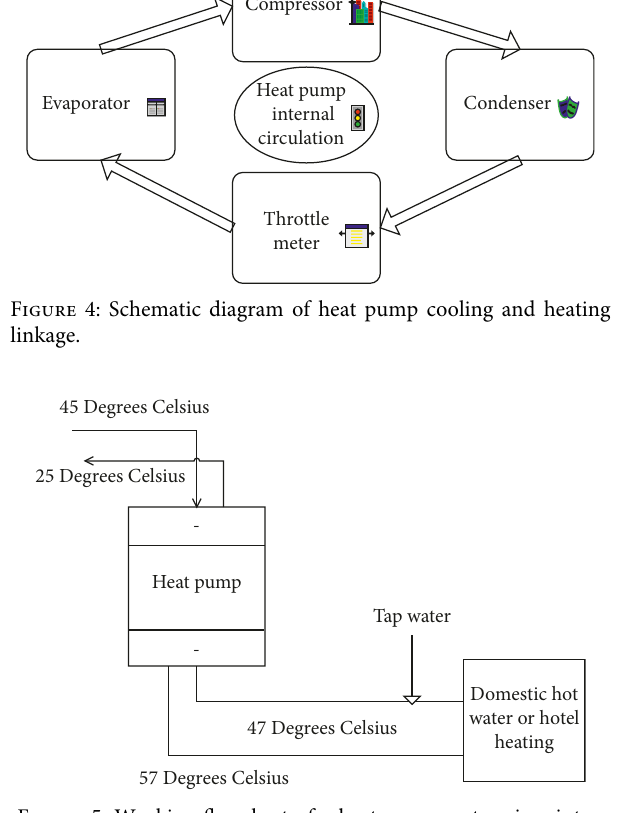
Figure 5: Working flowchart of a heat pump system in